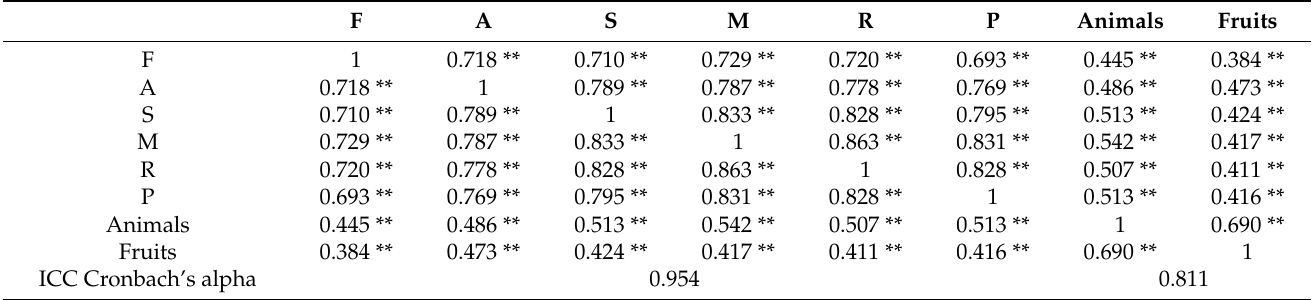
Table 4. Pearson correlation coefficients and interclass correlation coefficients between phonologic and semantic fluency. p < 0.01